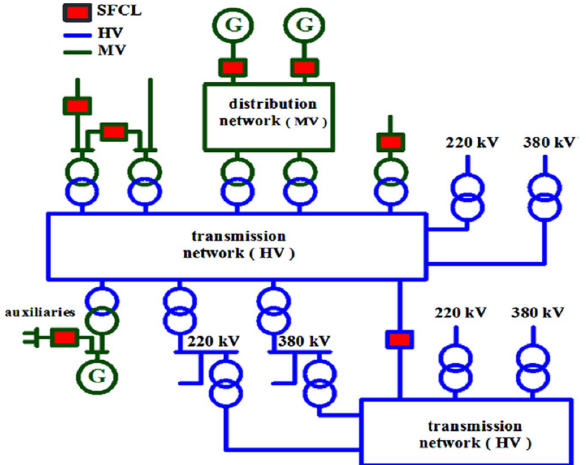
Figure 3. Possible applications of SFCLs in the power system [32].